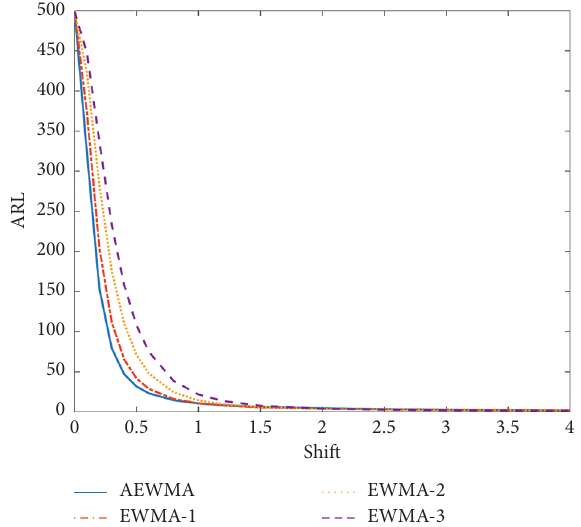
Figure 5: Variation of ARL with mean shift in the range 0–4 for the designed control 1